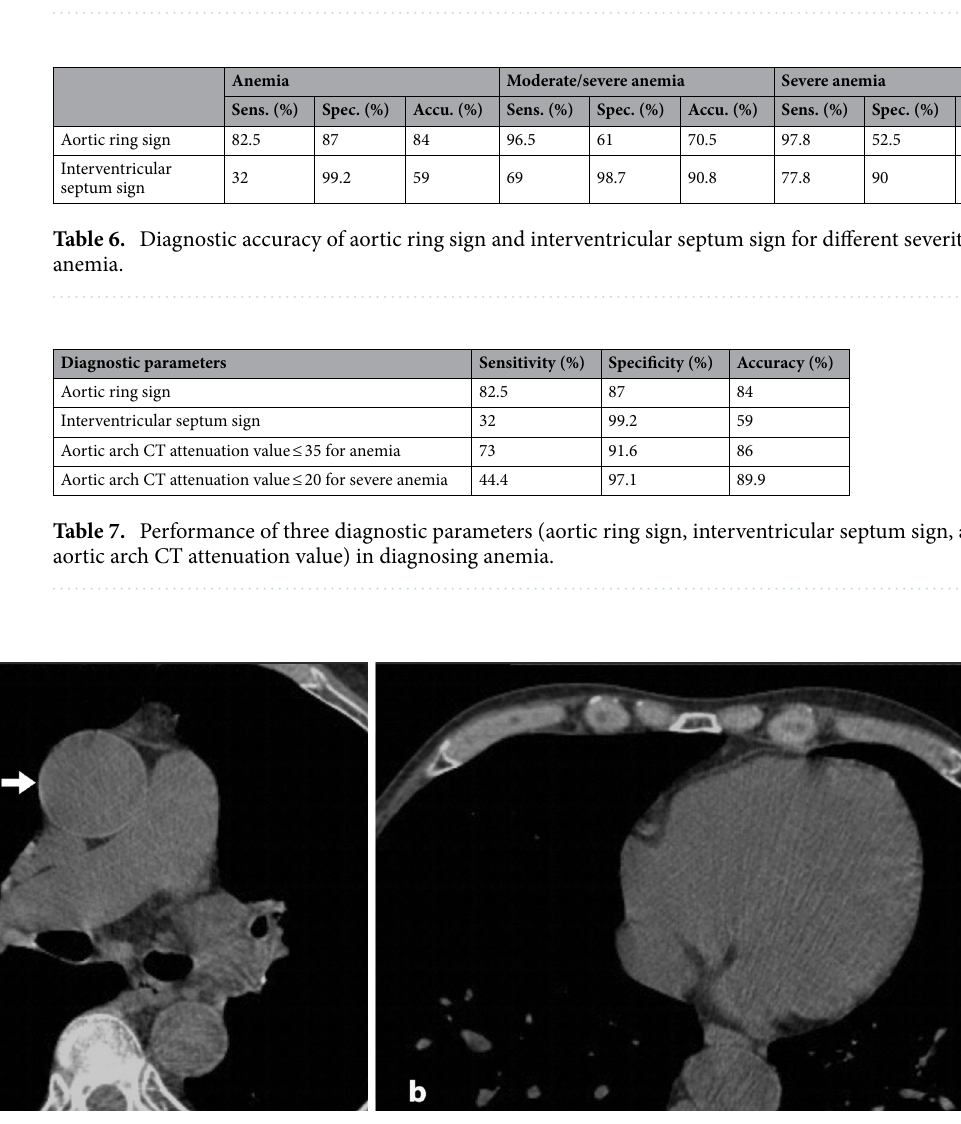
Table 5. Sensitivity, specificity, and accuracy for diagnosis of severe anemia at various threshold values of blood CT attenuation in different anatomic locations.